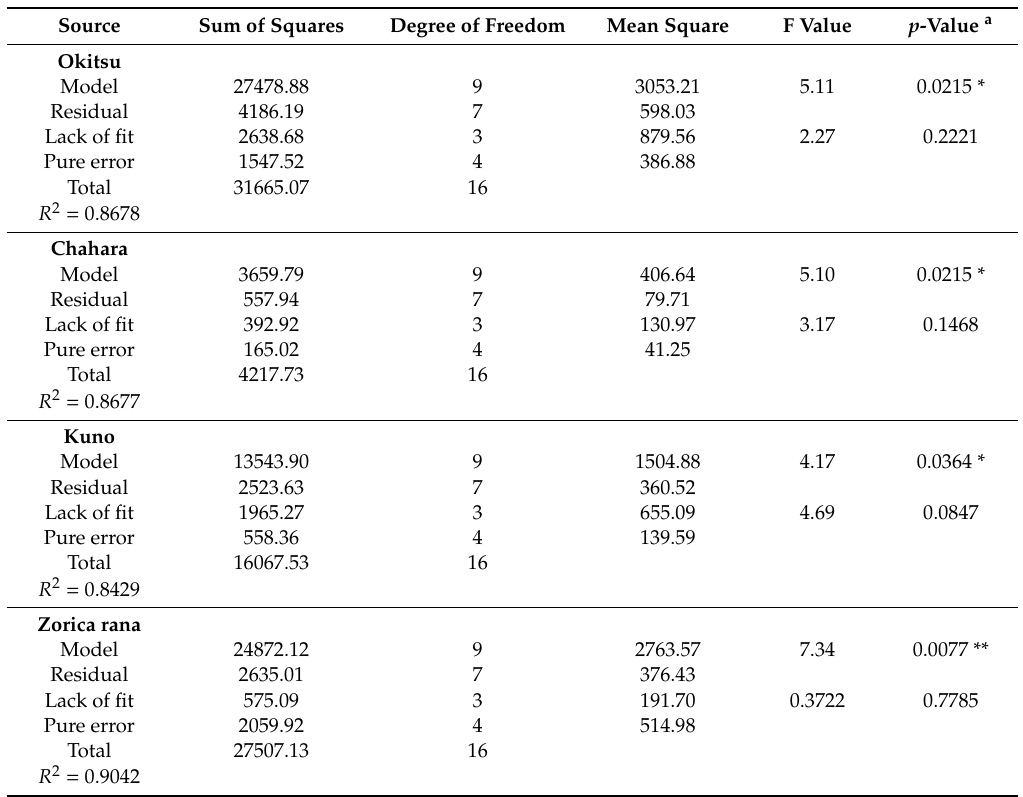
Table 3. Analysis of variance (ANOVA) of second-order polynomial models for hesperidin content in the mandarin